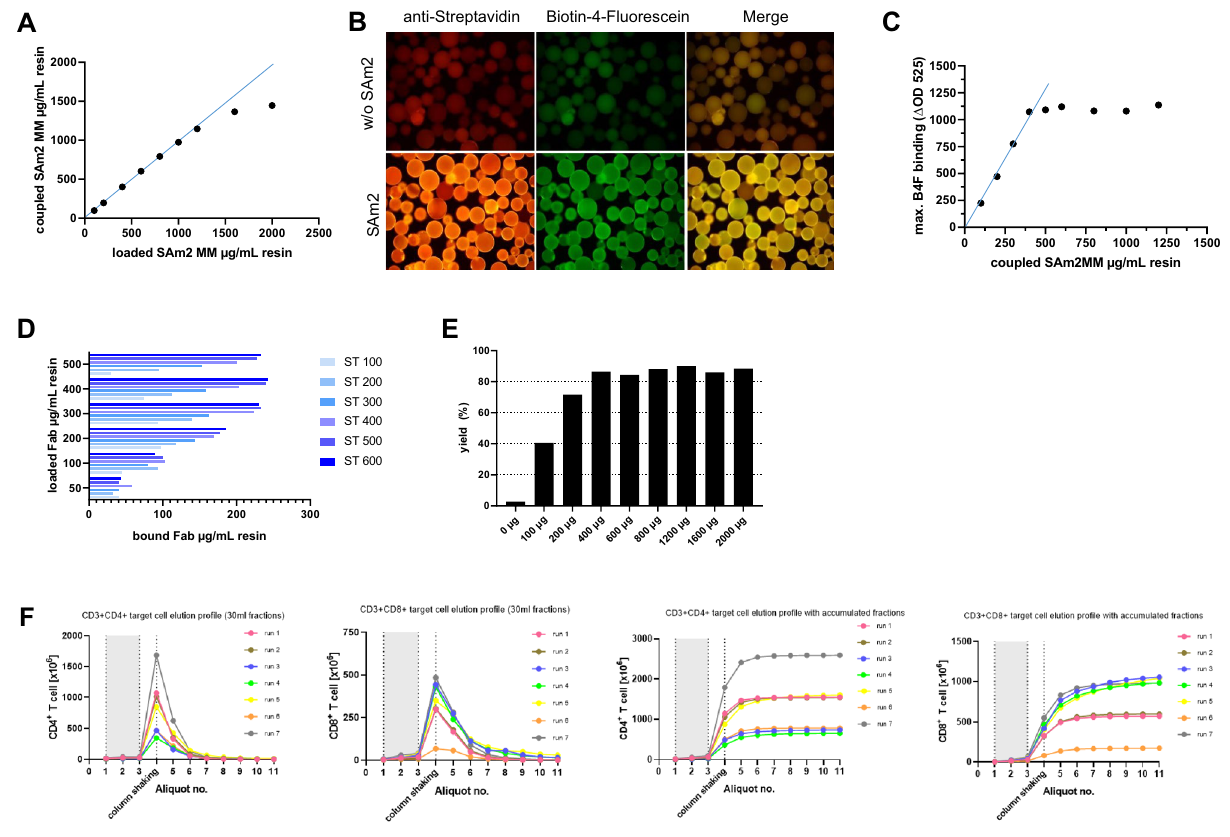
Figure 2. Development and characterization of the selection matrix towards the optimal target cell-capturing performance. ( A ) The linear portion for the immobilization of Strep-Tactin multimer backbone (SAm2 MM) to epoxy functionalized CytoSorbents base matrix is within 100–1000 µg Sam2 MM per mL reconstituted resin. Diagram shows the mean of 5 independent coupling reactions performed in PBS reaction buffer of pH 7.2. ( B ) Surface bound SAm2 MM retains the property to associate with biotin. Pictures show binding of the fluorescent biotin derivate Biotin-4-Fluorescein (FITC) to coupled CytoSorbents raw beads. Coupling reaction was performed in the presence (lower panels) or absence (upper panels) of 500 µg SAm2 MM. SAm2 MM coated surface is visualized by anti-Streptavidin-PE antibody staining. ( C ) The ability of surface bound Strep- Tactin to associate with biotin. The capacity for Strep-Tactin interaction on surface bound SAm2 MM was evaluated by Biotin-4-fluorescein (B4F) quenching assay. Diagram shows the mean of maximal B4F adsorption of three independent experiments. ( D ) Assessment of coupling of Fab fragments to the SAm2 MM. Diagram shows the quantity of Fab fragments bound to 1 mL column matrix dependent on the amount of surface bound SAm2 MM. Quantity of bound Fab fragments was calculated by quantifying residual protein content of Fab coupling solution after 1 h incubation time from the value initially loaded to SAm2 MM-coated matrixes. ( E ) Productivity of 1 mL selection matrix refers to the limit of functional coupleable SAm2 MM. CD3 + target cells were purified with increasing amounts of immobilized Fab fragment:SAm2 MM complex at constant ratio. Efficiency of T cell purification was calculated by the ratio of yielded T cell numbers related to the estimated T cell number based on their frequency in starting material. ( F ) Elution profiles of CD4 and CD8 target T cells for collected single fractions (left panels) and accumulated fractions (right panels) for seven independent cell selections performed on the ATC device with different target cell starting counts. Leukapheresis was used as a starting